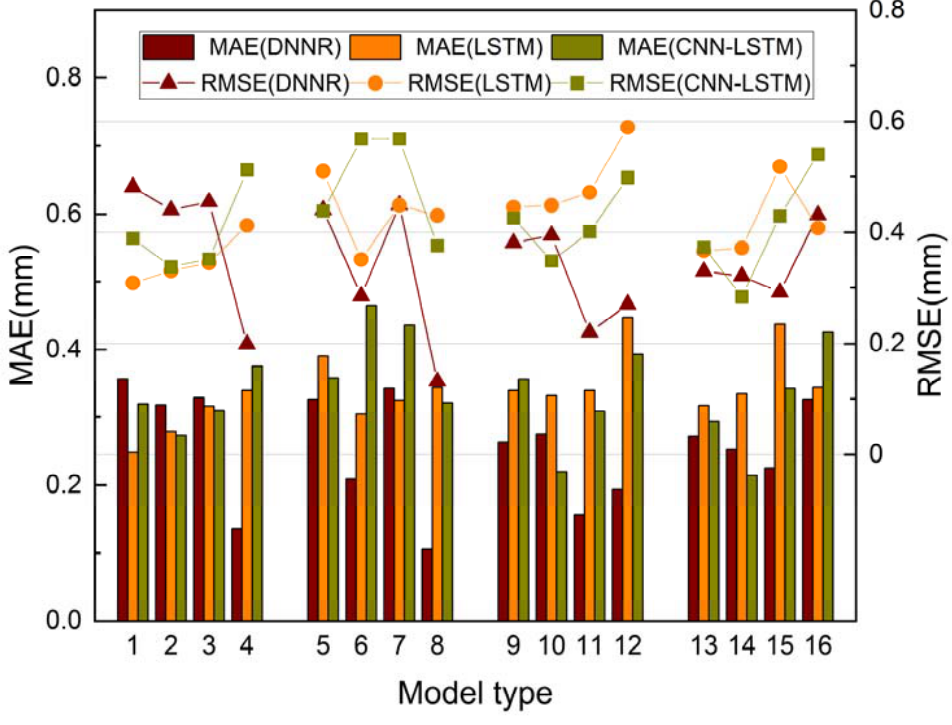
Figure 21. The RMSE and MAE of predictive daily ET o and actual ET o for Greenhouse A under four forecast time points.